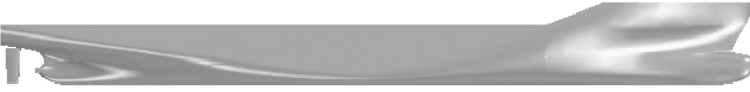
Figure 8. The geometry of the KCS model. Table 7. Main particulars of the monohull.